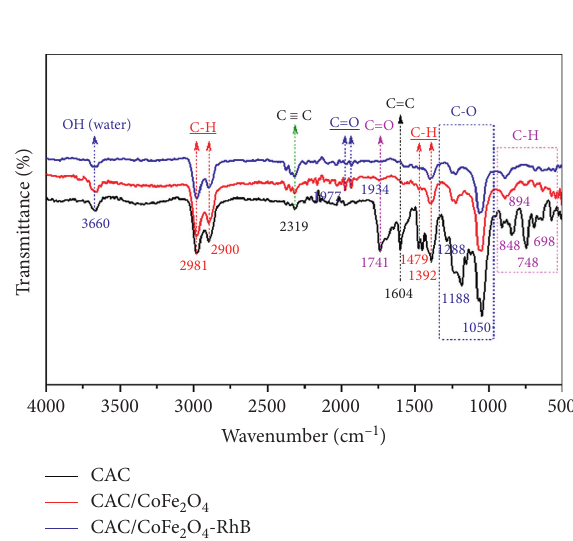
Figure 10: FTIR graph of CAC, CAC/CoFe CoFe 2 O 4